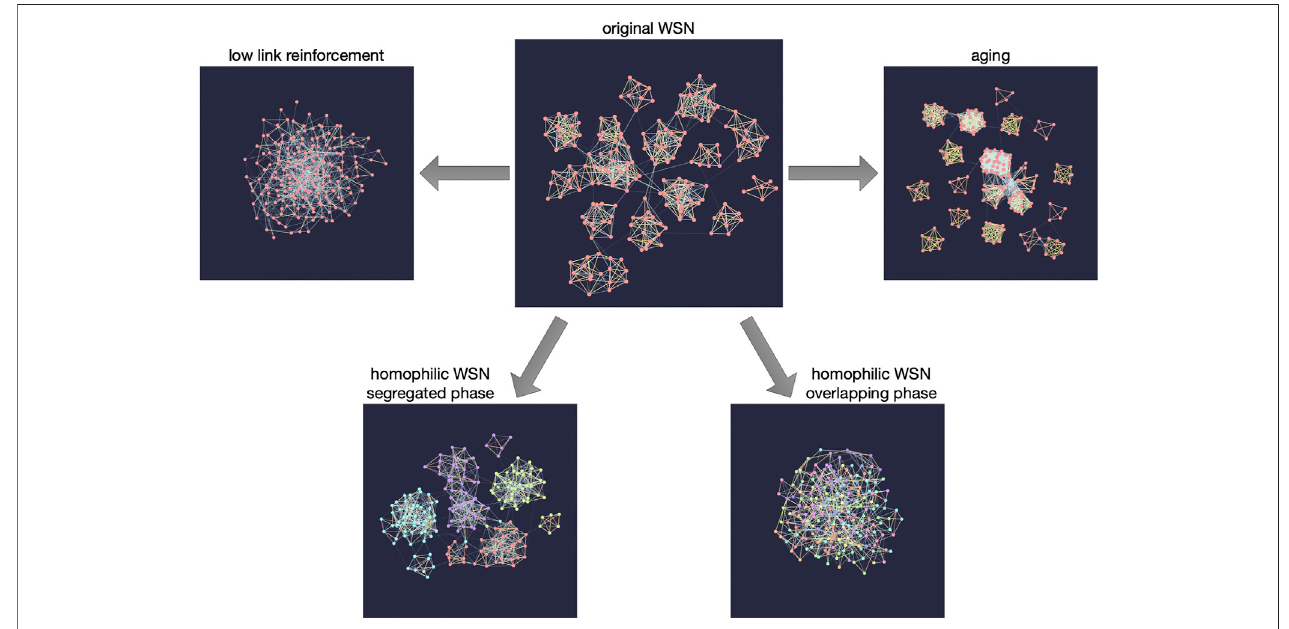
FIGURE1| SnapshotsofthenetworksgeneratedbytheGWSNmodelforvariouscombinationsofparametervaluesinthemodel.Thetopcenterpanelshowsthe networkgeneratedbytheoriginalWSNmodelshowingtheGranovetteriancommunitystructurewhenthelinksarereinforcedsuf fi ciently.TheGranovetteriancommunity structureisabsentwhenthelinkreinforcementisnothighenough,asshowninthetopleftpanel.Thetoprightpanelpresentsthenetworkwithhigherclusteringthanthe original WSN model when only the link aging mechanism is applied for the link termination. The bottom panels show the effect of homophilic interaction on the generated networks; depending on the parameter values, it shows the structural transition from the segregated, non-overlapping communities (bottom left) to the overlapping communities (bottom right)